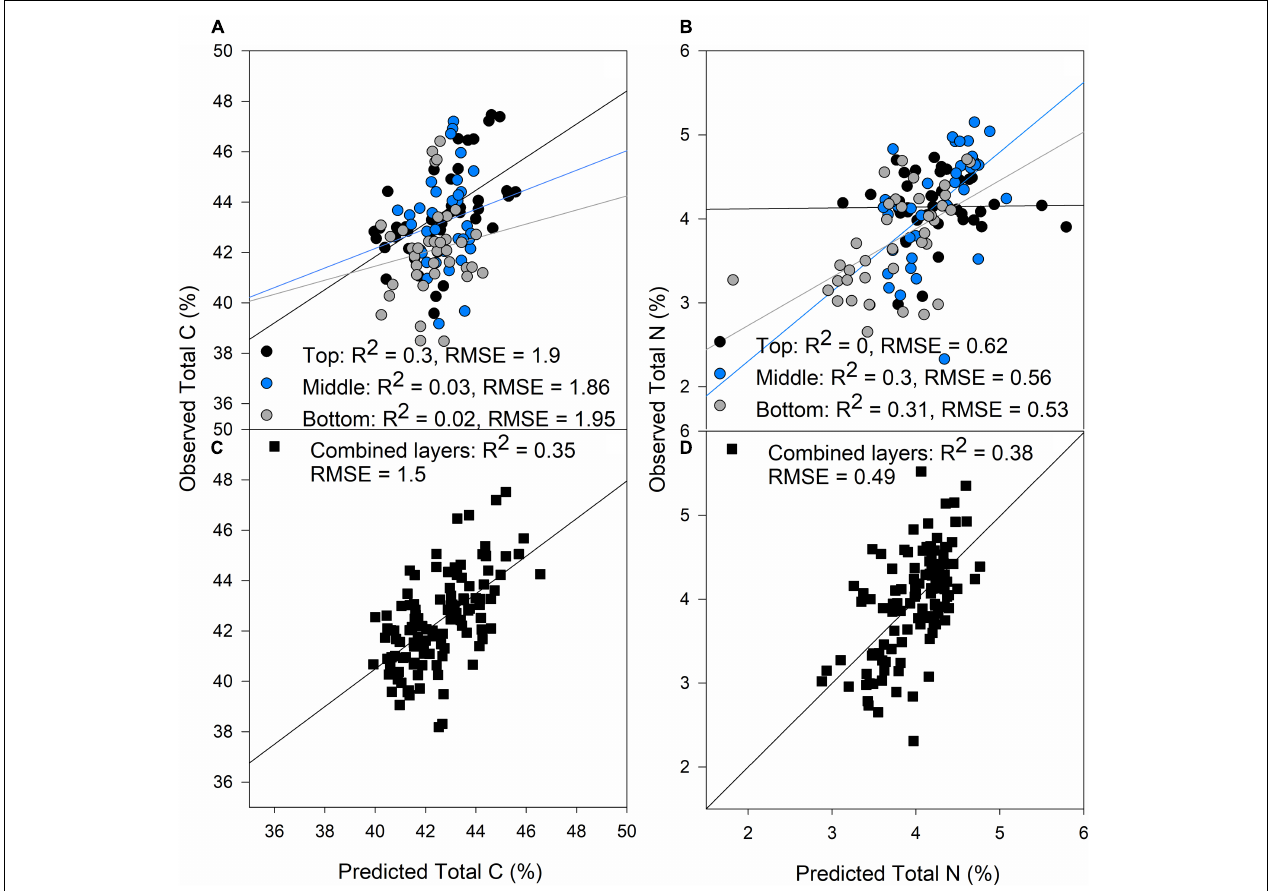
FIGURE 2 | Validation results of PLSR models predicting Total C (A) and Total N (B) by separating each layer of the canopy (top panels) and predictions of Total C (C) and Total N (D) combining all the layers of the canopy (black squares). Black dots: top of the canopy, blue dots: middle of the canopy, gray dots: bottom of the canopy. The lines represent the linear regression between predictions and ground truth